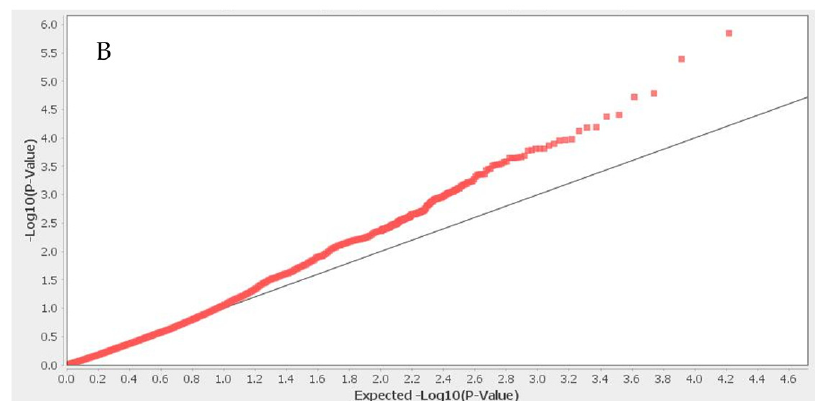
Figure 2. Manhattan plot ( A ) and q–q plot ( B ) of coat color for white color. Red line in Manhattan plot is Bonferroni threshold. The chromosomal position of each SNP was displayed in different colors in Manhattan plot. Red and gray line in the q–q plots represent the − log p -value of the entire study and expected value, respectively.